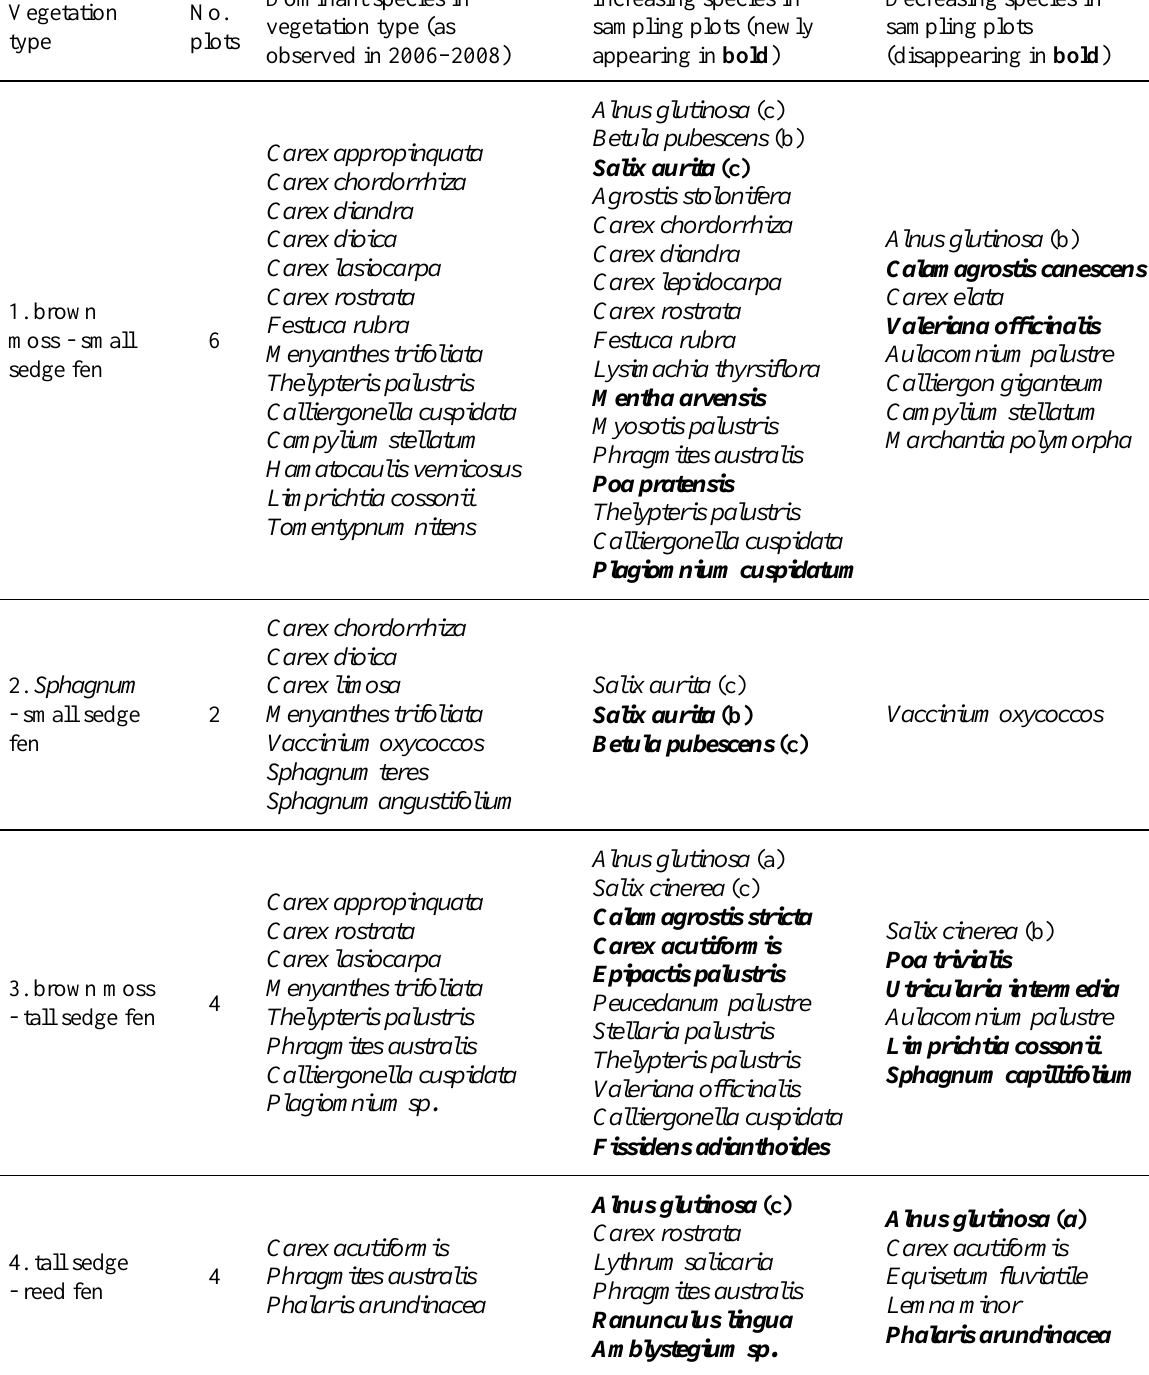
Table A2. Change in species composition between 2006–2008 and 2016, in the same sampling plots located in eight vegetation types. A change (increase or decrease) was recorded if the cover of a species increased (or decreased) by at least two points on the Braun-Blanquet scale if only two relevés were available to represent the vegetation type, or by at least one point on the Braun-Blanquet scale if data from more than two relevés were available for comparison. Letters in parentheses indicate the vegetation layer in which a shift in cover of the species occurred, where alternatives are possible: (a) = tree layer; (b) = shrub layer; (c) = herb layer. Decreasing species in sampling appearing in bold )